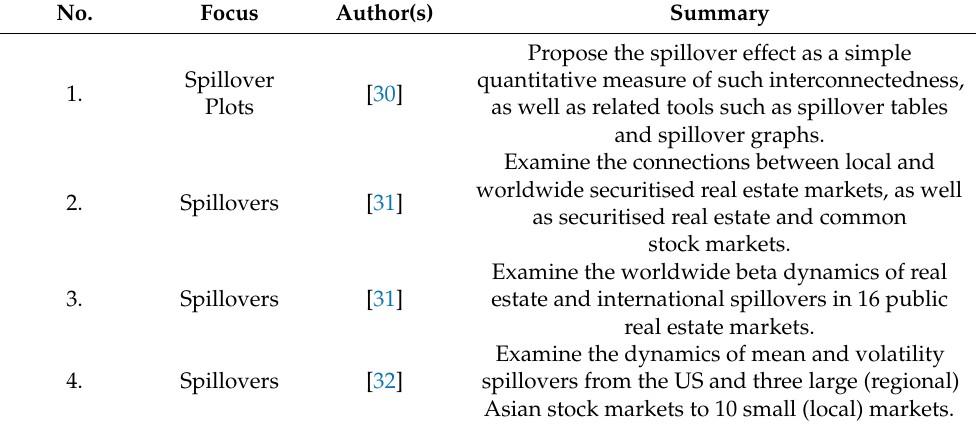
Table 1. Summary the Major Studies on the Volatility Spillover Effect in the Asian Property Market.